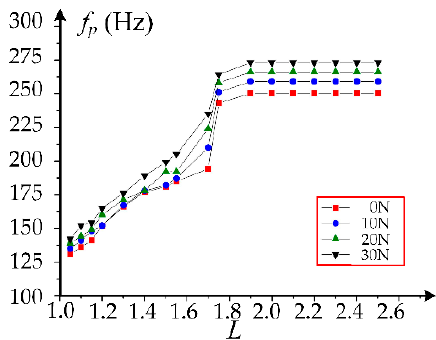
Figure 16. Peak vibration frequency with different radial loads.